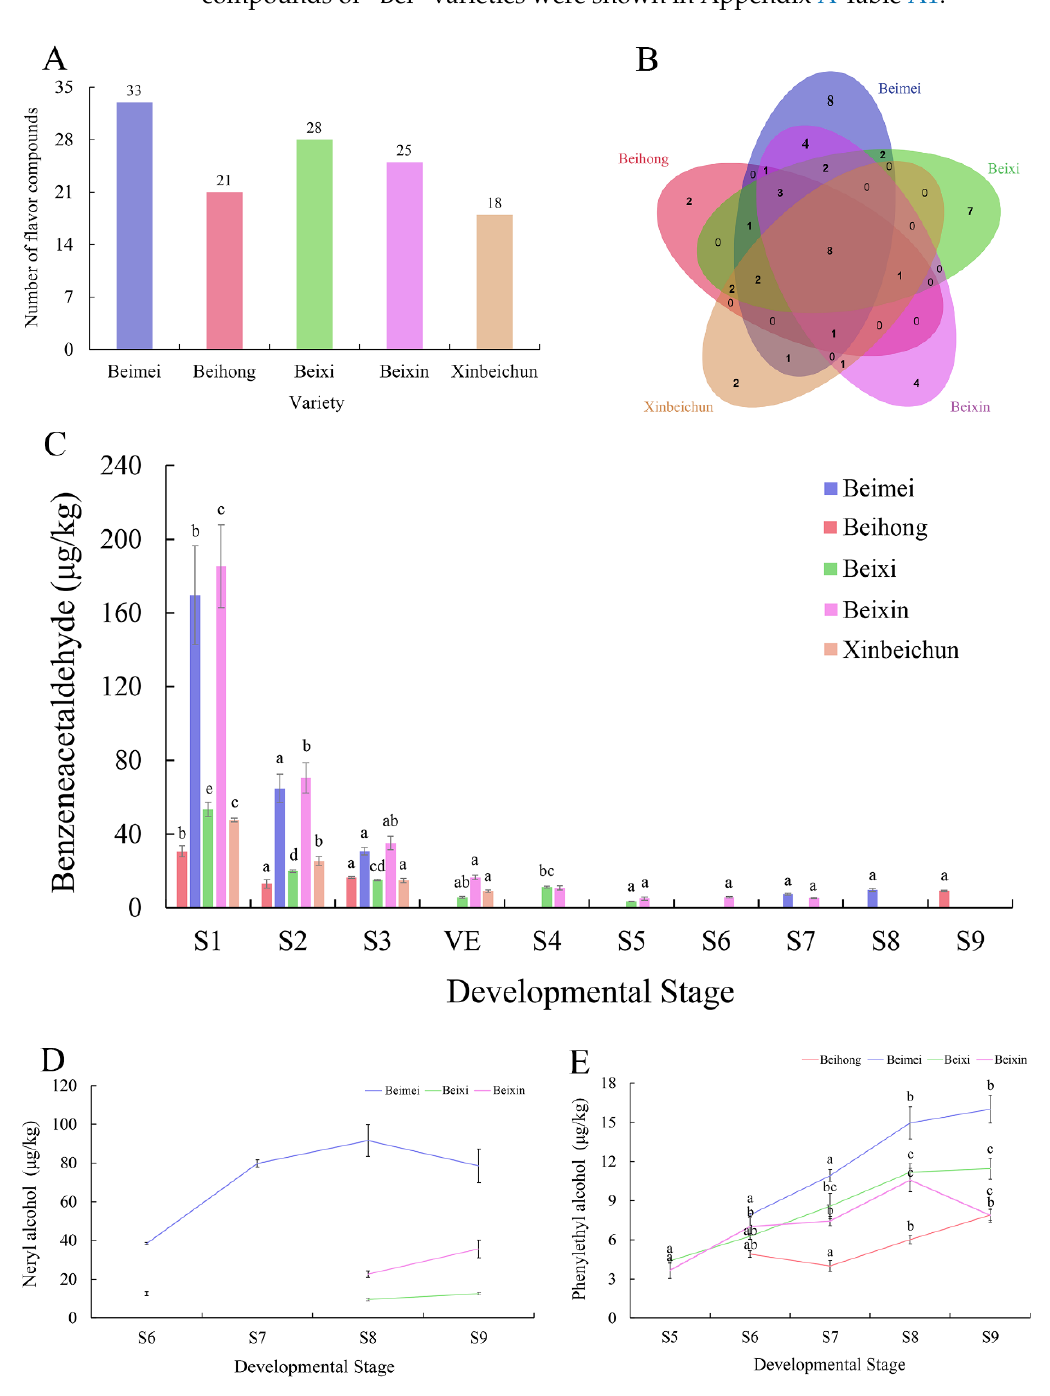
Figure 8. Analysis of ‘Beimei’ and other wine grape varieties’ flavor compounds. ( A ) The number is the sum of compounds in all different stages of each variety of “Bei” wine grape varieties. ( B ) Difference analysis of all flavor compounds of “Bei” wine grape varieties. Different color represents